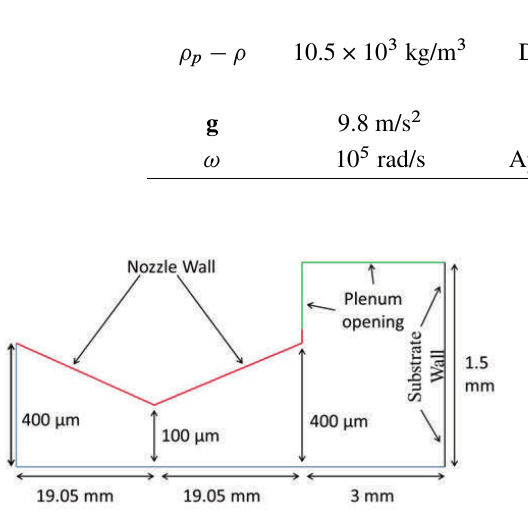
Figure 1. Illustration of axisymmetric converging-diverging micro-nozzle